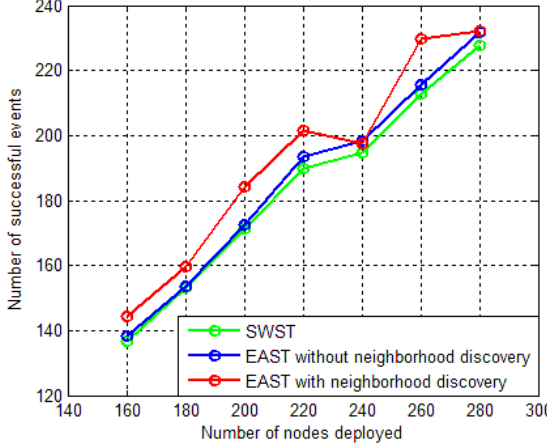
Fig. 8. Effect of the number of nodes deployed over the number of successful events for SWST, EAST without neighborhood discovery and EAST with neighborhood discovery algorithms